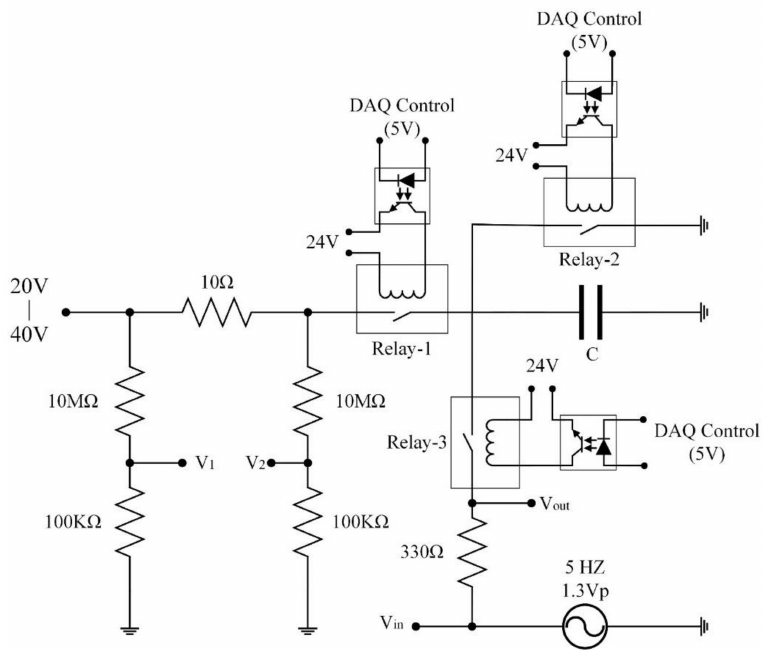
Figure 3. An electrical system used to evaluate the entropy generation in commercial